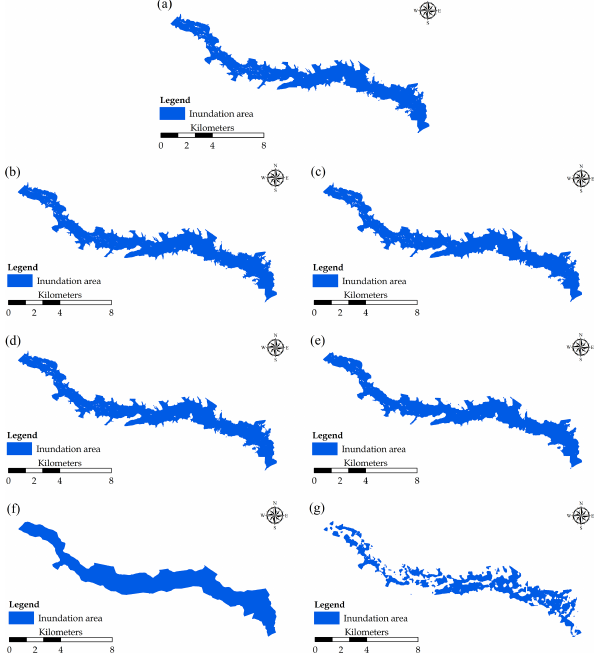
Figure 5. Effect of DEMs on Johor River. Inundation map resulting from (a) Jhr L1, (b) Jhr L2, (c) Jhr L20, (d) Jhr L30, (e) Jhr L90, (f) Jhr T20 and (g) Jhr